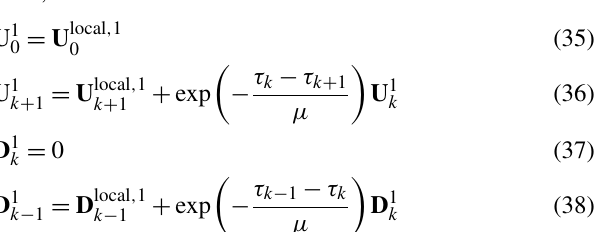
tions, which are more efficient to